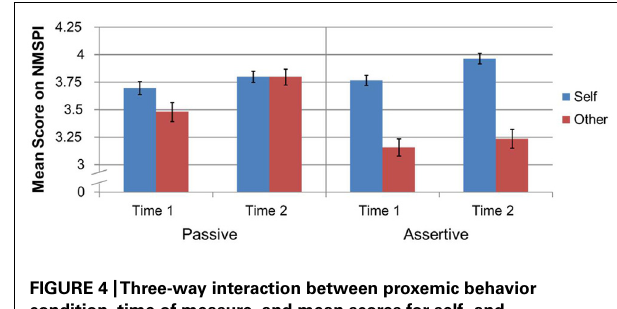
FIGURE 4 |Three-way interaction between proxemic behavior condition, time of measure, and mean scores for self- and other-attributions as measured by the